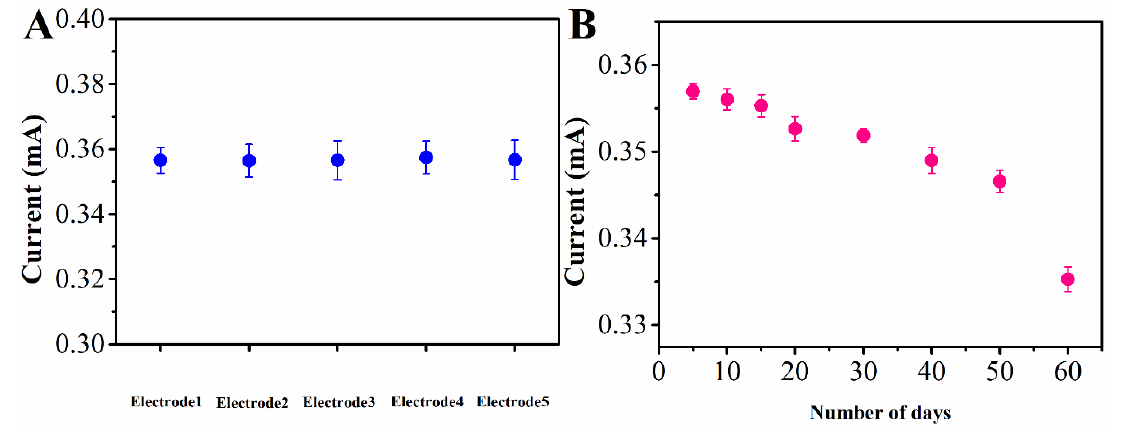
Figure 5. ( A ) Reproducibility study of CPE/TiO 2 /(CS+AuNPs)/anti-ProGRP/BSA/ProGRP immunoelectrode in the presence of ProGRP (300 ng/mL). ( B ) The stability curve of CPE/TiO 2 /(CS+AuNPs)/anti-ProGRP/BSA/ProGRP immunoelectrode in the presence of ProGRP (300 ng/mL) in a period of 0–30 days. Table 1. Comparison of electrochemical immunosensor and the enzyme-linked immunosorbent assays (ELISA) method for the determination of ProGRP in serum samples.